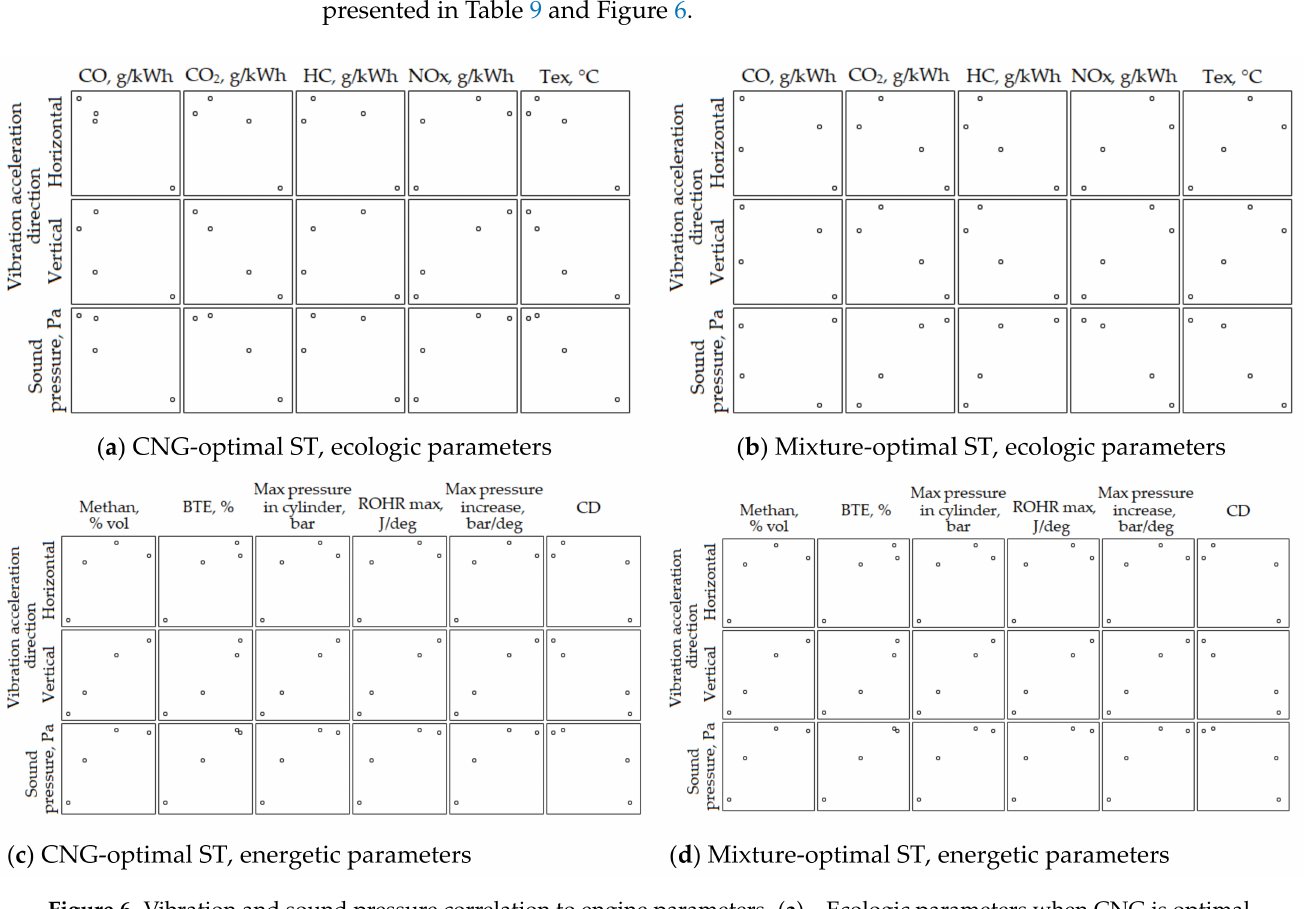
Figure 6. Vibration and sound pressure correlation to engine parameters. ( a )—Ecologic parameters when CNG is optimal for ST; ( b )—ecologic parameters when ST is optimal for mixture; ( c )—energy parameter when CNH is optimal for ST; ( d )—energy parameter when ST is optimal for